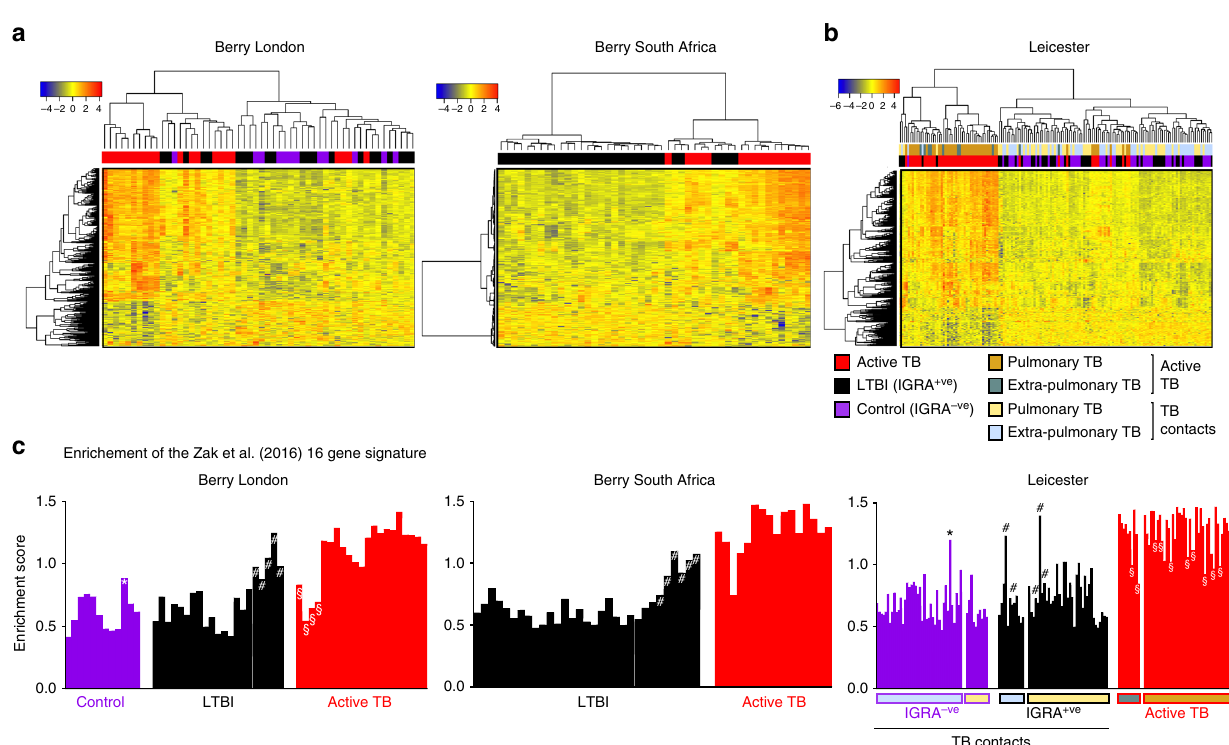
Fig. 2 Whole-blood transcriptional gene signatures in TB. a Heatmaps depicting unsupervised hierarchical clustering of active TB (red), LTBI (black) and control samples (purple) using a 373-gene signature derived using the Berry London cohort, tested in the Berry South Africa cohort, and b validated in an independent cohort from Leicester. Gene expression values were averaged and scaled across the row to indicate the number of standard deviations above (red) or below (blue) the mean, denoted as row Z -score. c Bar graphs depicting enrichment scores derived on a single sample basis using ssGSEA in the Berry London, Berry South Africa and Leicester cohorts using the 16-gene signature from Zak et al. 32 . Purple, black and red bars represent control, LTBI and active TB samples, respectively, and * (control outliers), # (LTBI outliers) and § (active TB outliers) represent the outlier samples identi fi ed by